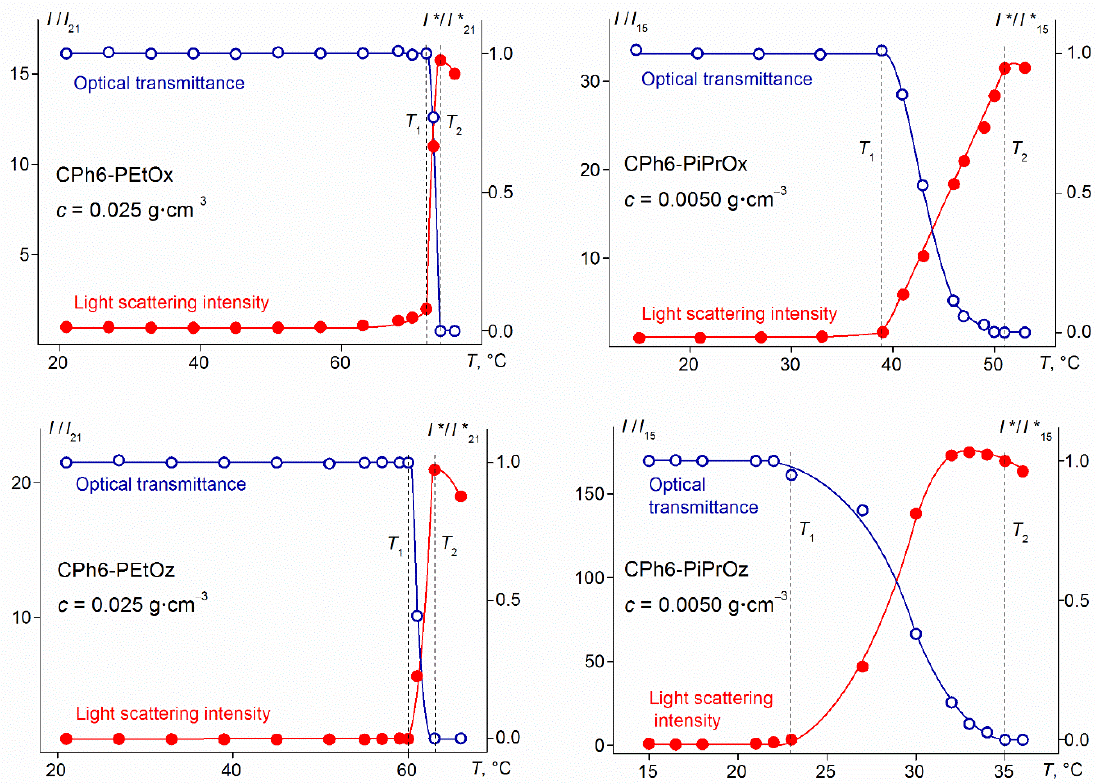
Figure 5. Temperature dependences of relative light scattering intensity I / I 15 and I / I 21 and relative transmission I */ I * 15 and I */ I * 21 for solutions of investigated star polymers. I 15 and I 21 are light scattering intensity at 15 °C and 21 °C, respectively. I * 15 and I * 21 are optical transmission at 15 °C and 21 °C, respectively.